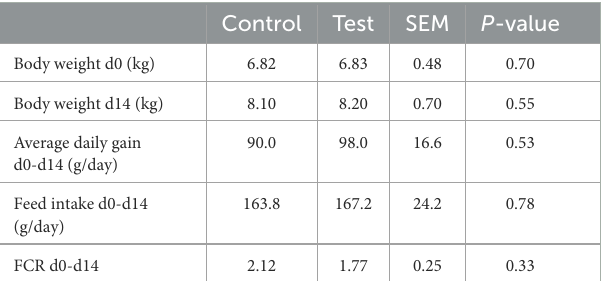
TABLE 4 Fecal consistency, diarrhea incidence and antibiotic treatment incidence of piglets fed a control diet (Control; n = 10) or a